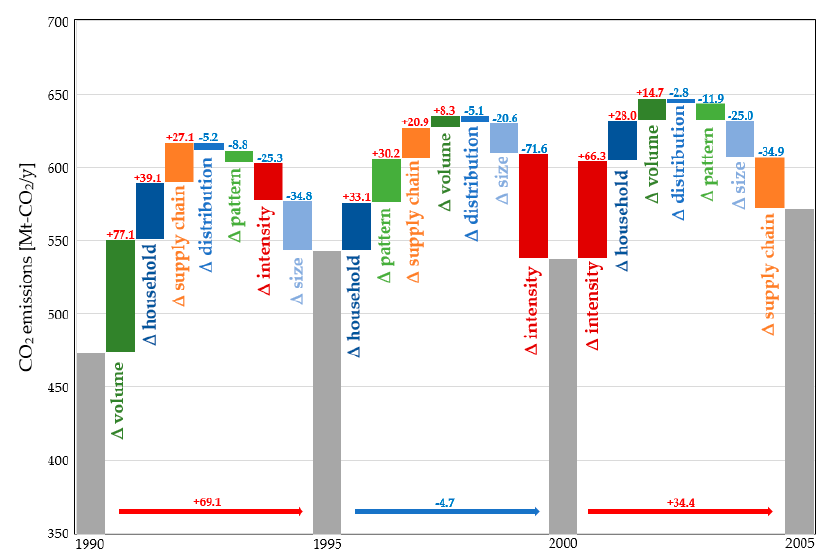
Figure 5. Driving forces of indirect CO 2 emissions during 1990–2005. ∆ intensity is the intensity effect, ∆ supply chain is the supply chain structure effect, ∆ pattern is the consumption pattern effect, ∆ volume is the consumption volume effect, ∆ size is the household size effect, ∆ distribution is the household distribution effect, and ∆ household is the household number effect.